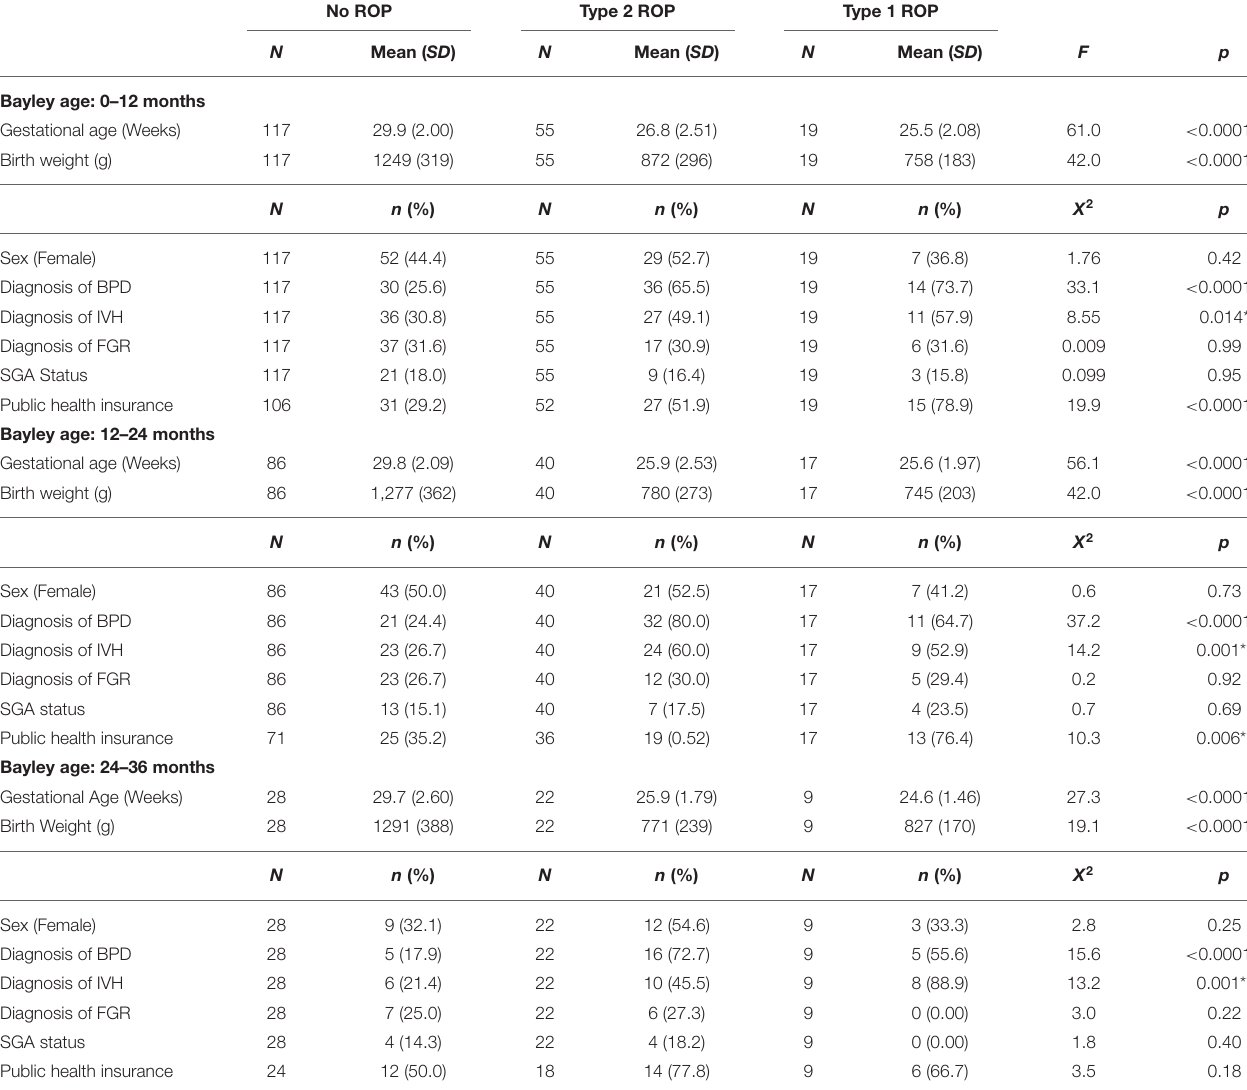
TABLE 1 | Summary of demographic data and clinical outcomes for infants with no ROP, type 2 ROP, and type 1 ROP. No ROP Type 2